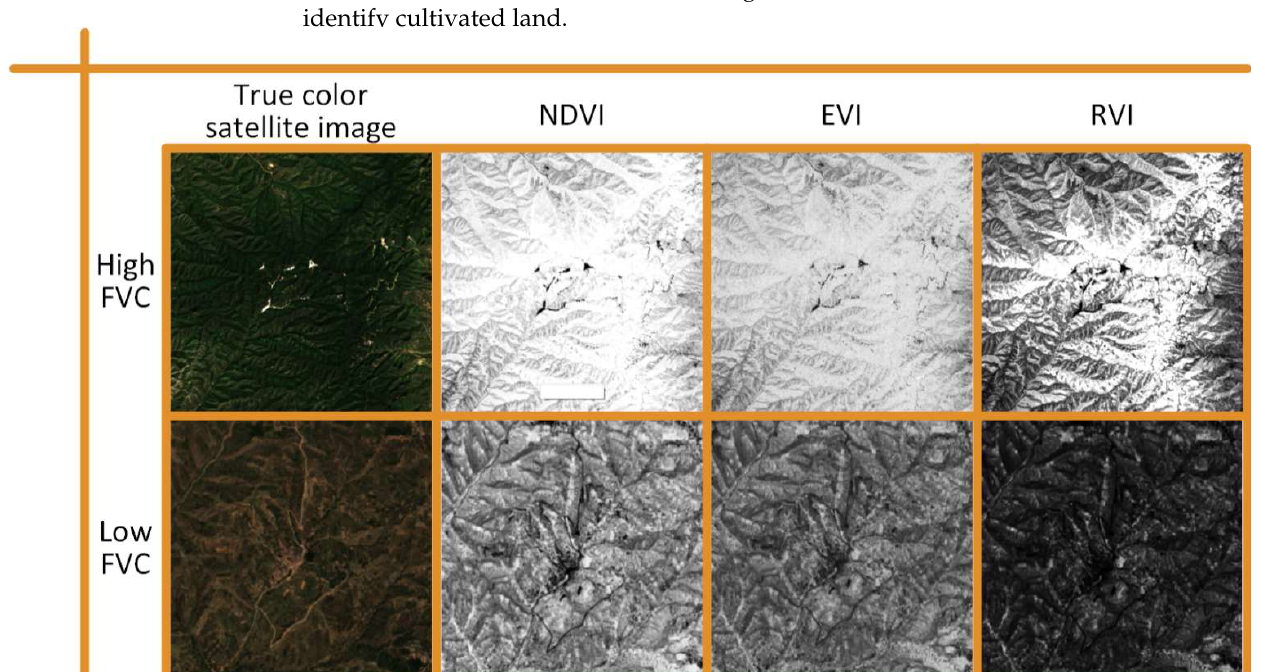
Figure 6. Comparison of the sensitivity of each vegetation index to different FVC areas.